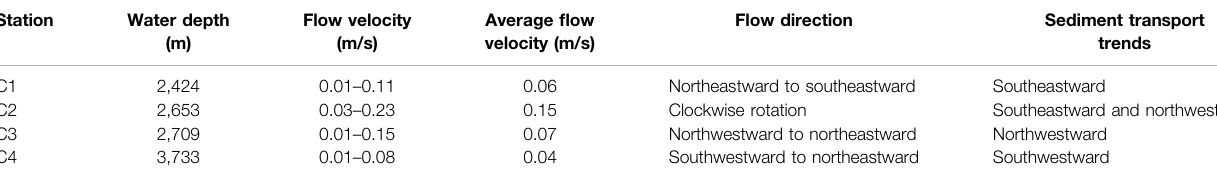
TABLE 3 | Flow velocity and direction of deep currents and the associated sediment transport trends. Station